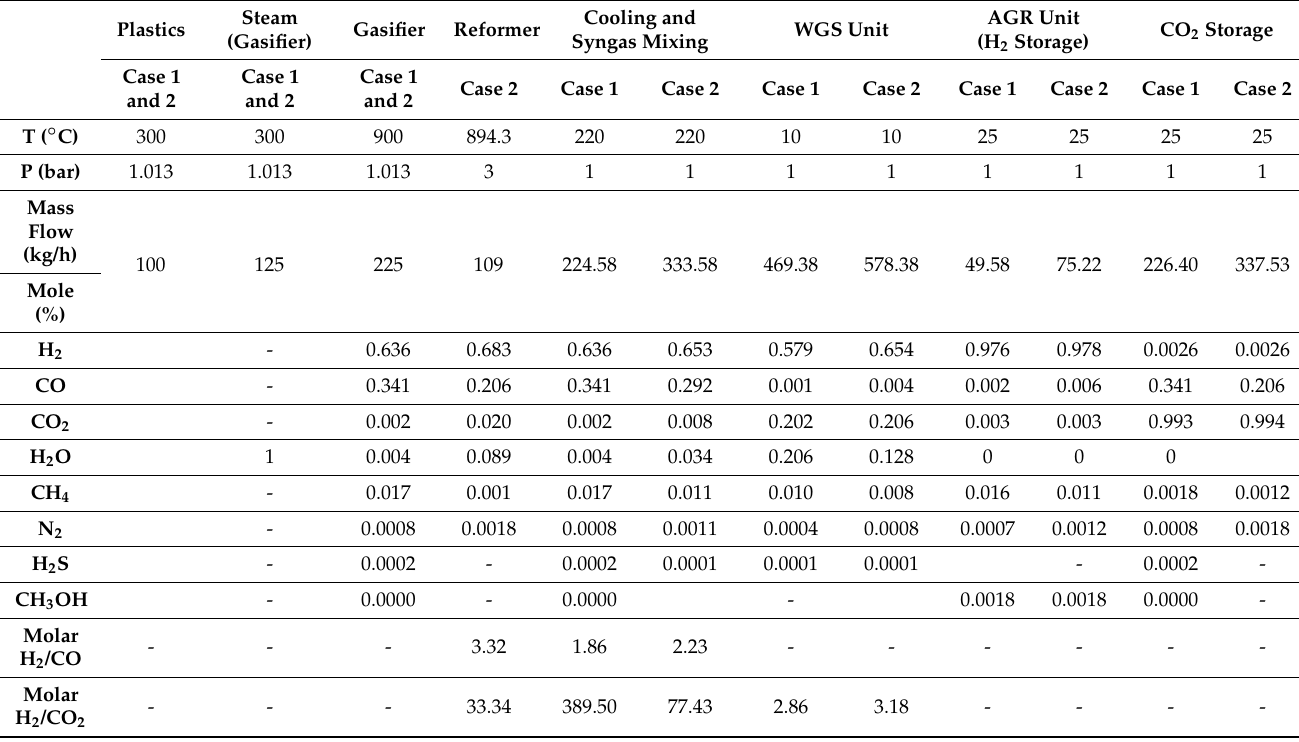
Table 4. Flow rates and stream compositions at the exit of each